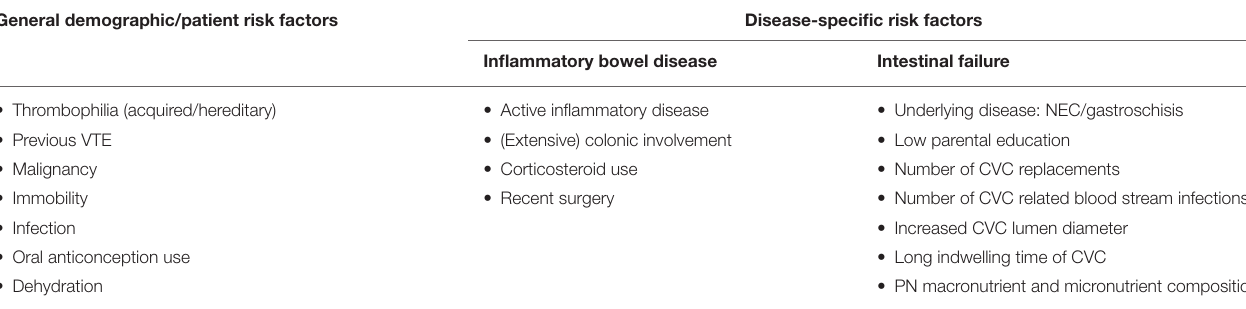
TABLE 1 | Risk factors for developing venous thromboembolic events in children with inflammatory bowel disease and/or intestinal failure. General demographic/patient risk